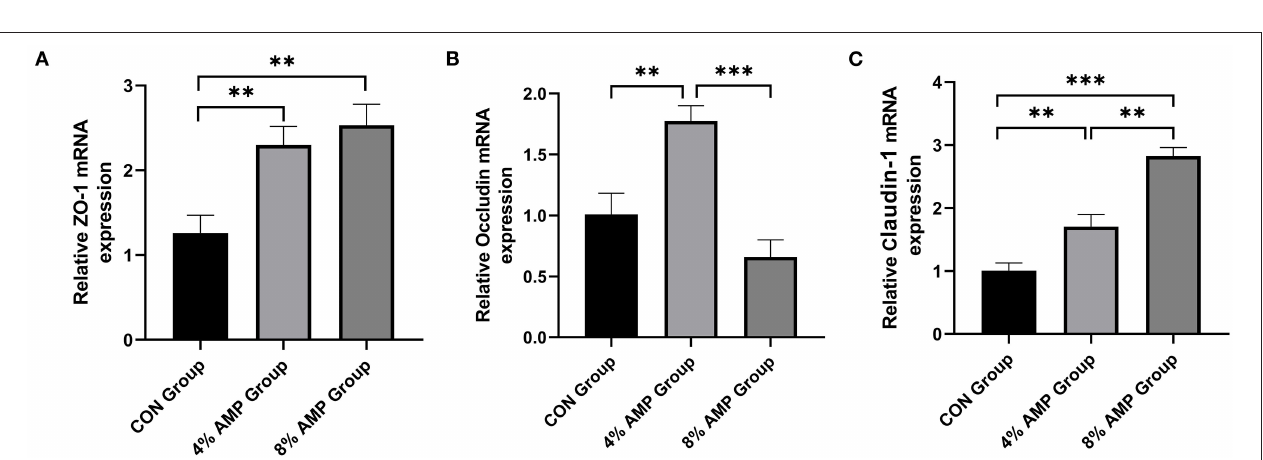
FIGURE 4 | Effect of dietary AMP supplementation on the gene expression of inflammatory cytokines in the jejunum of pigs. (A) Interleukin (IL)-1 β ; (B) IL-6; (C) IL-8; (D) IL-10; (E) Tumor Necrosis Factor (TNF)- α . Data are expressed as the means ± SDs, n = 6, * P < 0.05, ** P < 0.01, *** P < 0.001.